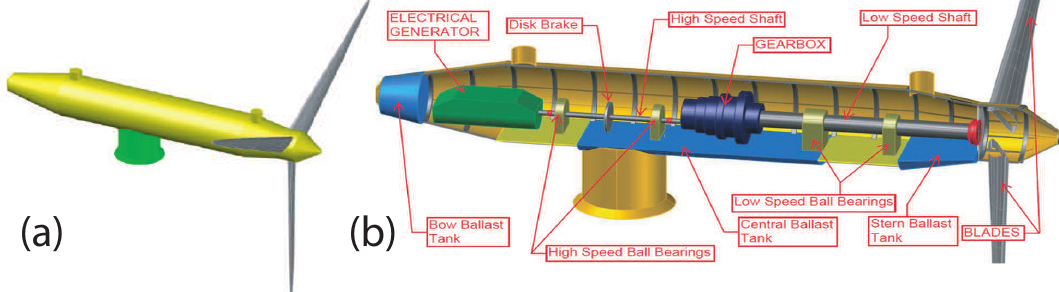
Figure 8. First generation TEC designed for automated maneuvers: ( a ) shape of the gondola and ( b ) distribution